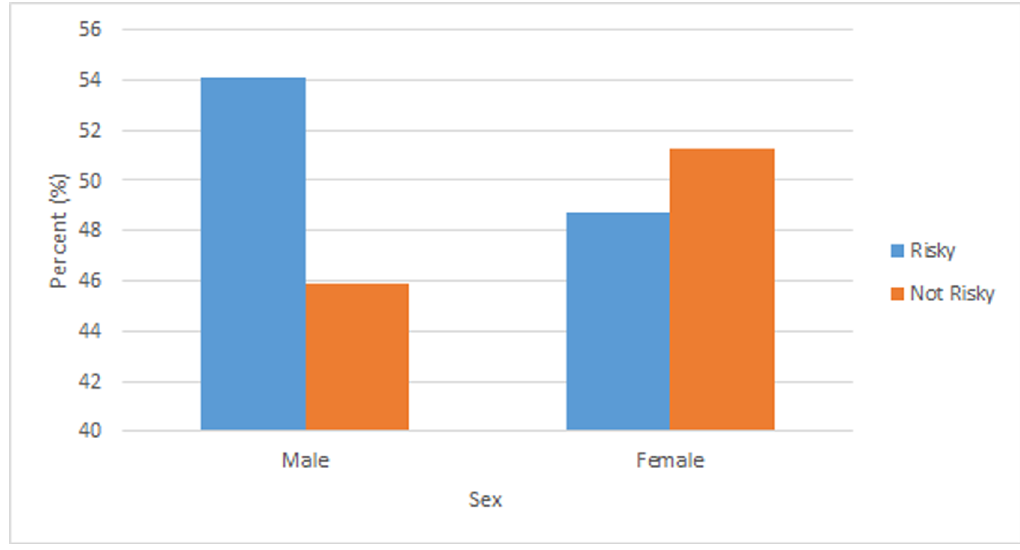
Fig 2. Weighted percentage distribution of percentage of community safety by sex among youth, South Africa, 2008.